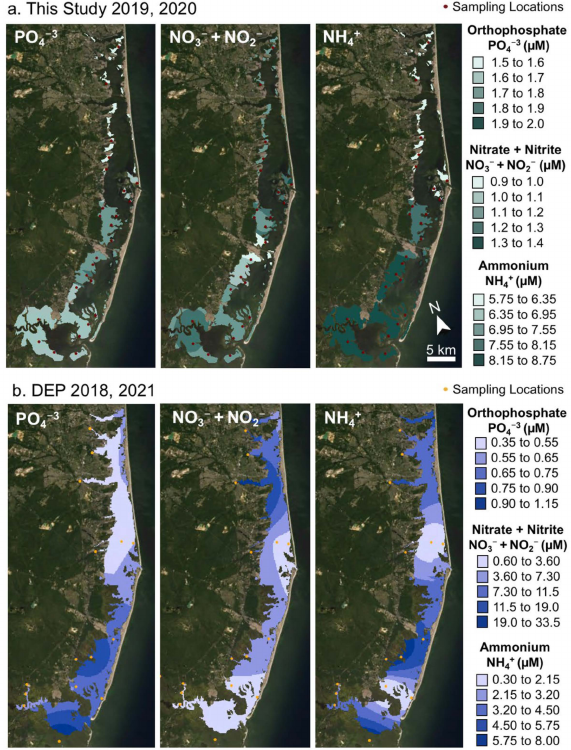
Figure 7. Interpolated ( a ) water quality data collected in this study from tidal marsh channels, and ( b ) open bay water quality samples collected in 2018 and 2021. For tidal marsh channels, ammonium values have a pronounced north to south gradient, with lower values in the north, and higher values in the south. For open water samples, the lowest values are found for dissolved inorganic nitrogen near the tidal inlets. For open water samples, phosphate shows a north to south gradient, with greater values in the south. Imagery source: Esri World Imagery acquired in June 2020.